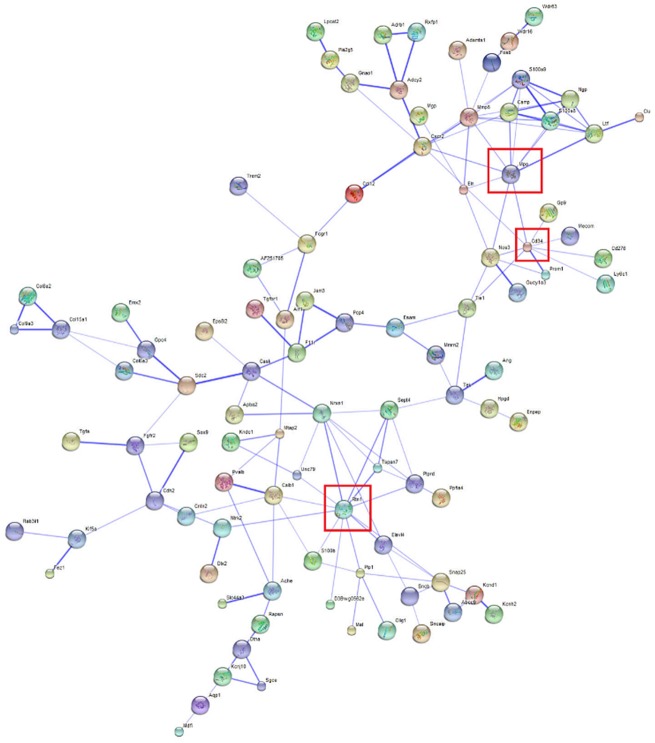
Network of genes over-expressed genes in microglia relative to macrophages in wild type mice (|log2(fold change)| > 6, FDR-adjusted P-value < 5.0 x 10−5) visualized using STRING.Edges represented by thicker lines denote stronger associations than thinner lines. Node size reflects the structural information associated with the protein coded by the gene. The node color facilitates visualization. Framed genes (red square) are discussed.